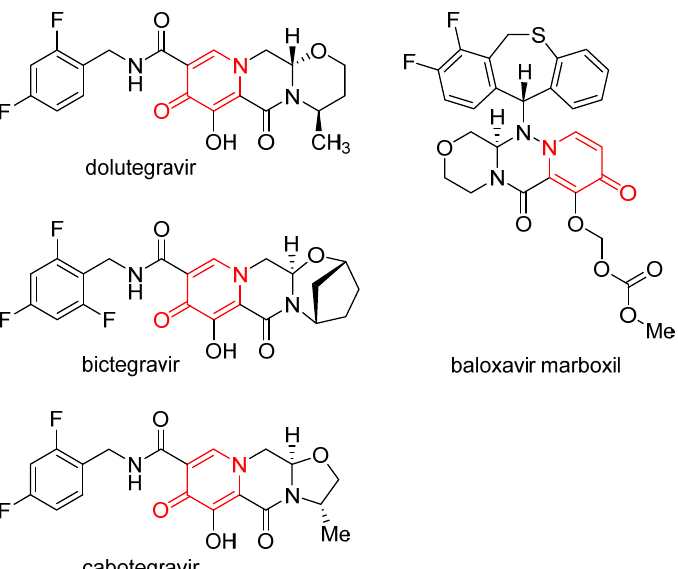
Figure 1. Some important polycyclic 4 ‐ pyridones.